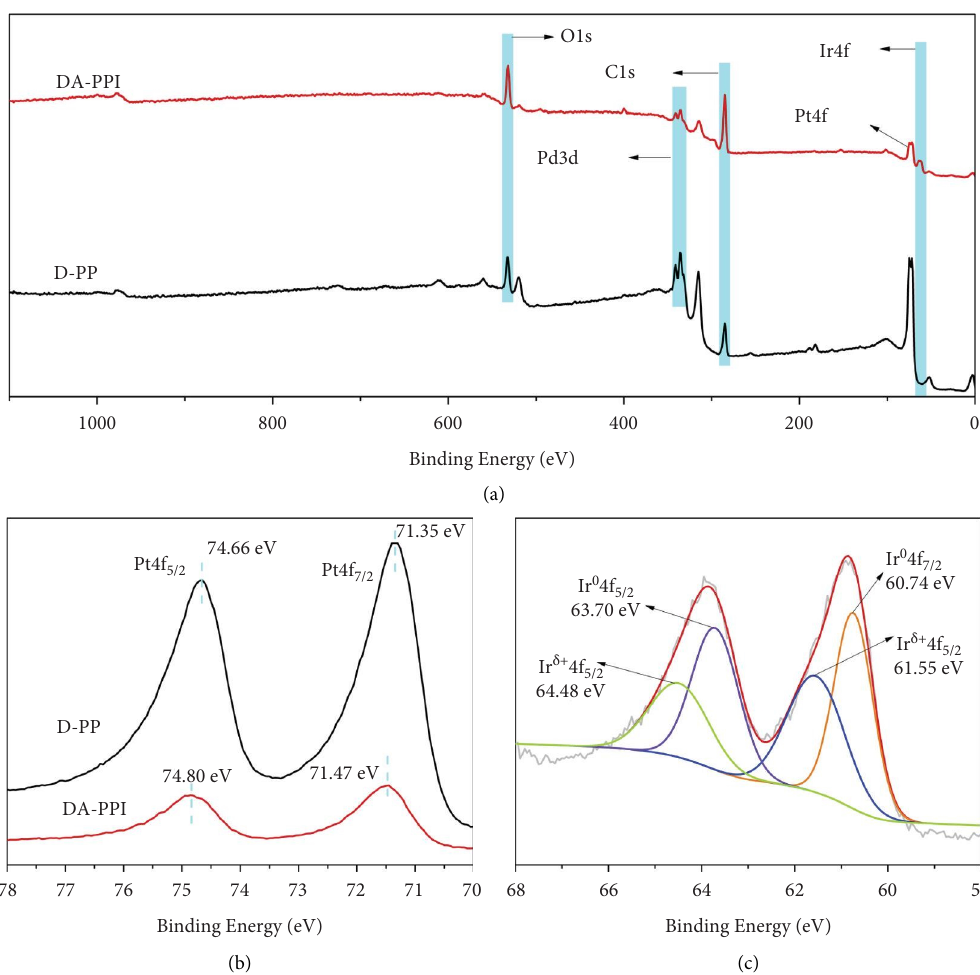
Figure 2: Te XPS broad spectrum of D-PP nanozyme and DA-PPI nanozyme (a). Te XPS narrow spectrum of Pt in D-PP nanozyme and DA-PPI nanozyme (b). Te XPS narrow spectrum of Ir in DA-PPI nanozyme